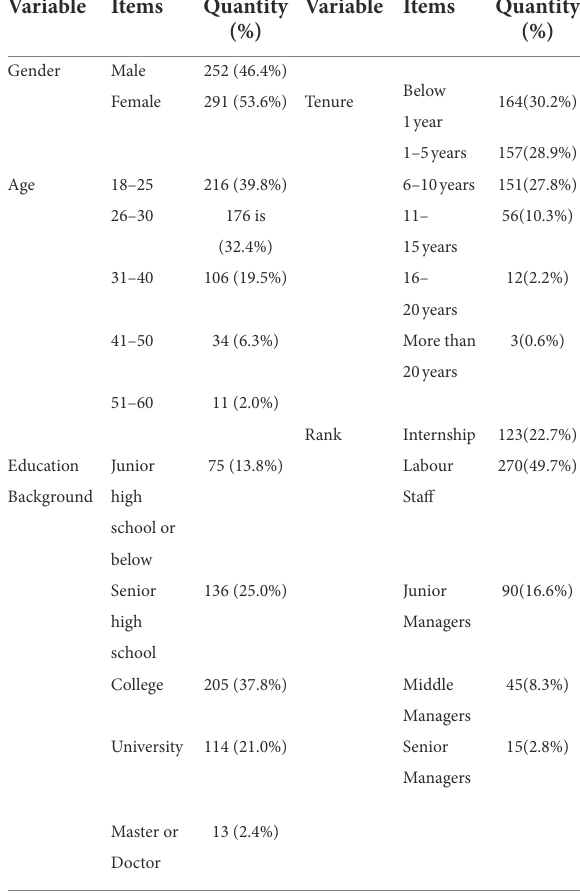
TABLE 1 Background of participants ( N =